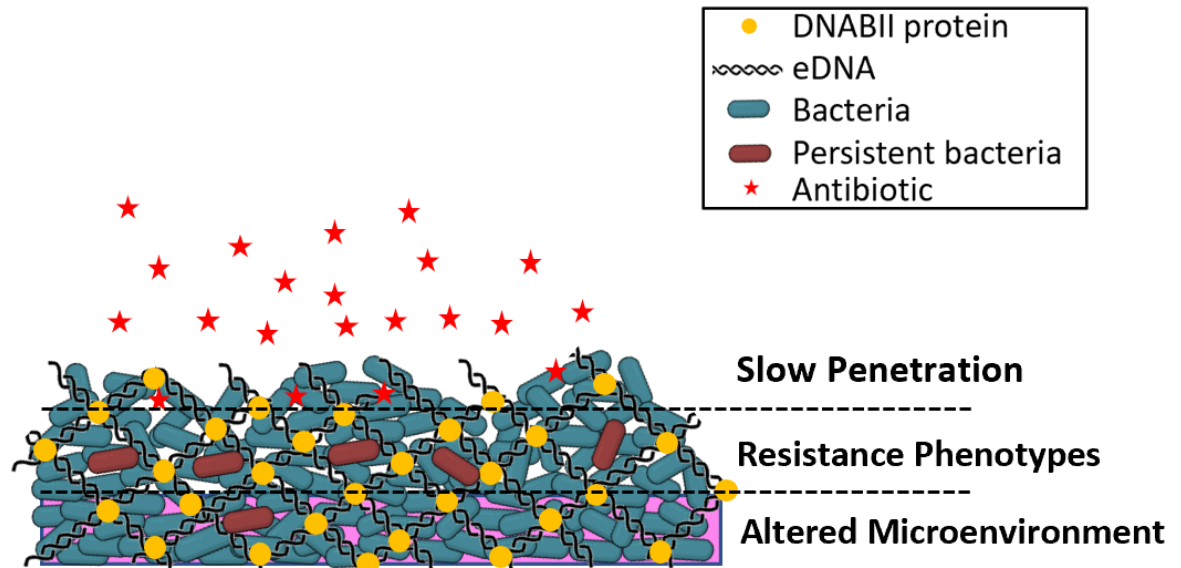
Figure 1. Illustration of biofilm structure in the context of the development of bacterial resistance. Slow penetration — antibiotics (red stars) may fail to penetrate beyond the surface of the biofilm. Resistant phenotypes — bacteria may develop persister cell phenotypes and undergo lateral transfer of genetic resistance elements; bacterial growth rates and metabolic activities are altered from plank- tonic bacteria. Altered microenvironment — nutrient depletion and accumulation of waste within the biofilm antagonizes the action of antibiotics. Adapted from Reference [32].